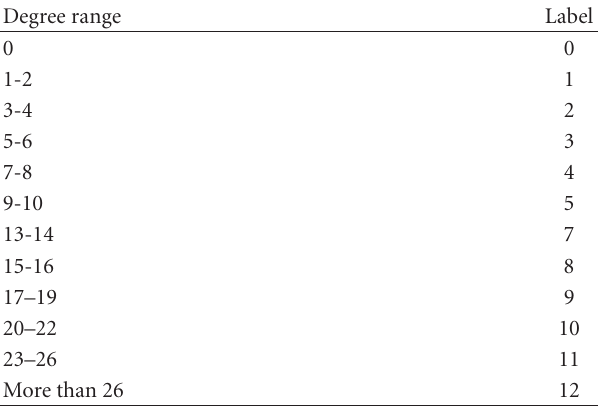
Table 2: Labeling scheme to capture local degree of subgraph